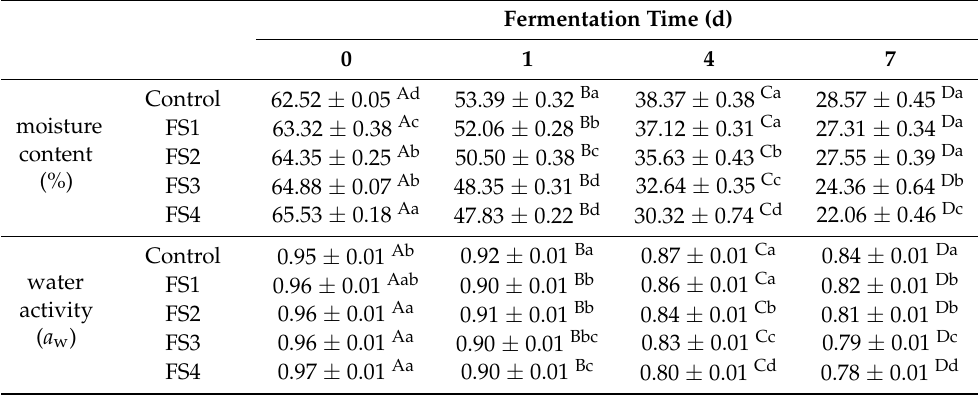
Table 3. Changes in moisture content (%) and water activity ( a w ) of Harbin dry sausages with different replacement levels of CFS during